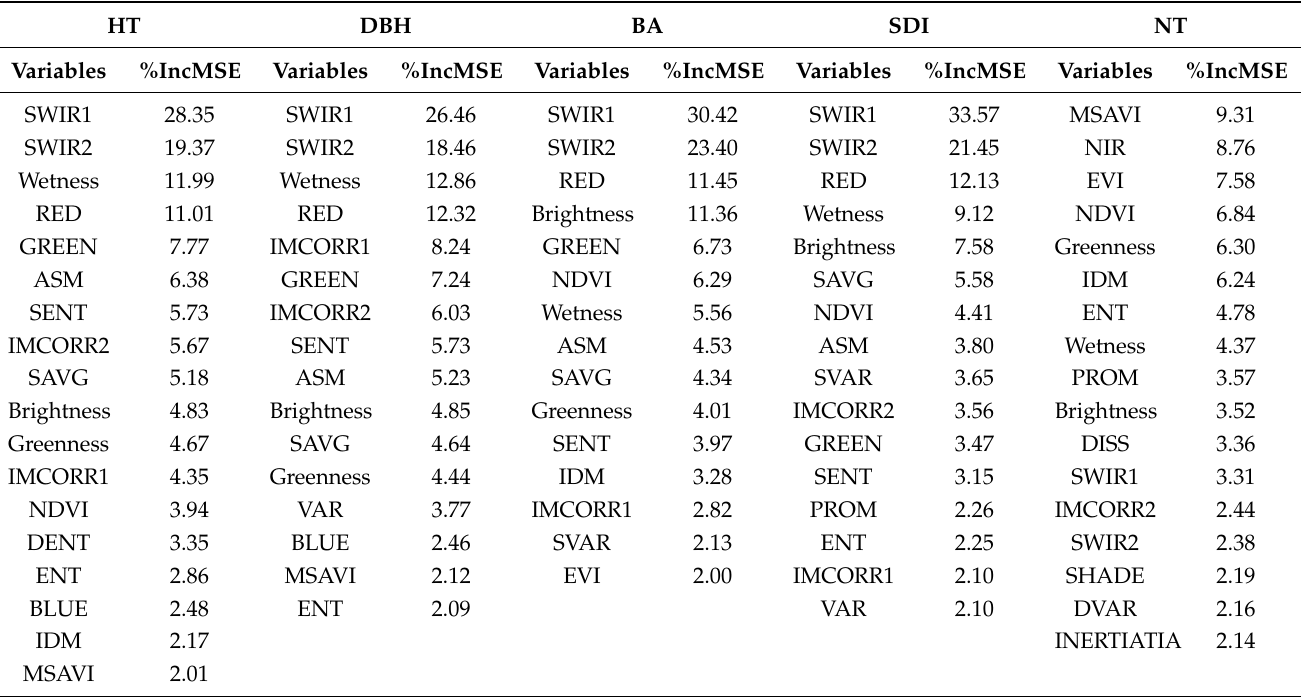
Table 5. Relative importance of predictors with %IncMSE ≥ 2 by random forests models using the training dataset for the 1st cycle measurement.